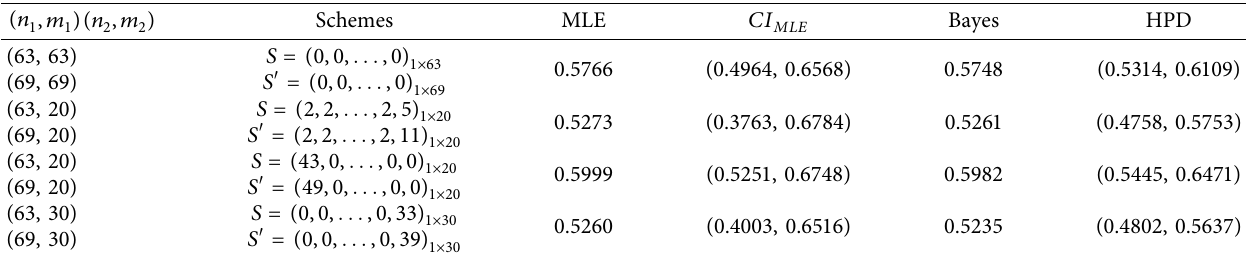
Table 7: The ML, Bayes estimations, and %95 asymptotic confidence/HPD interval of R using real dataset. n , m n , m 1 1 )( 2 2 (